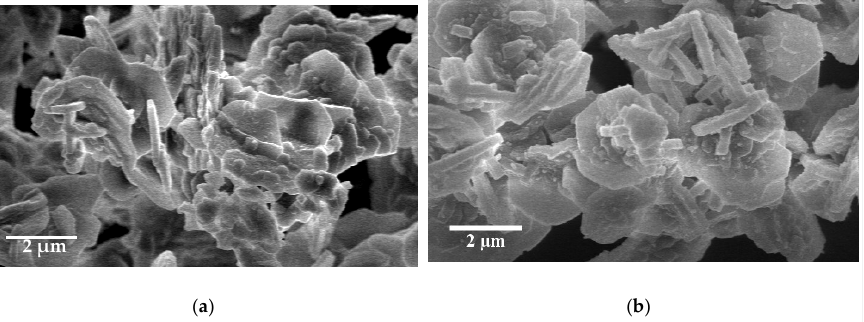
Figure 2. Scanning electron microscopy micrographs of: ( a ) SBA-S; ( b ) Ti-SBA-S materials.